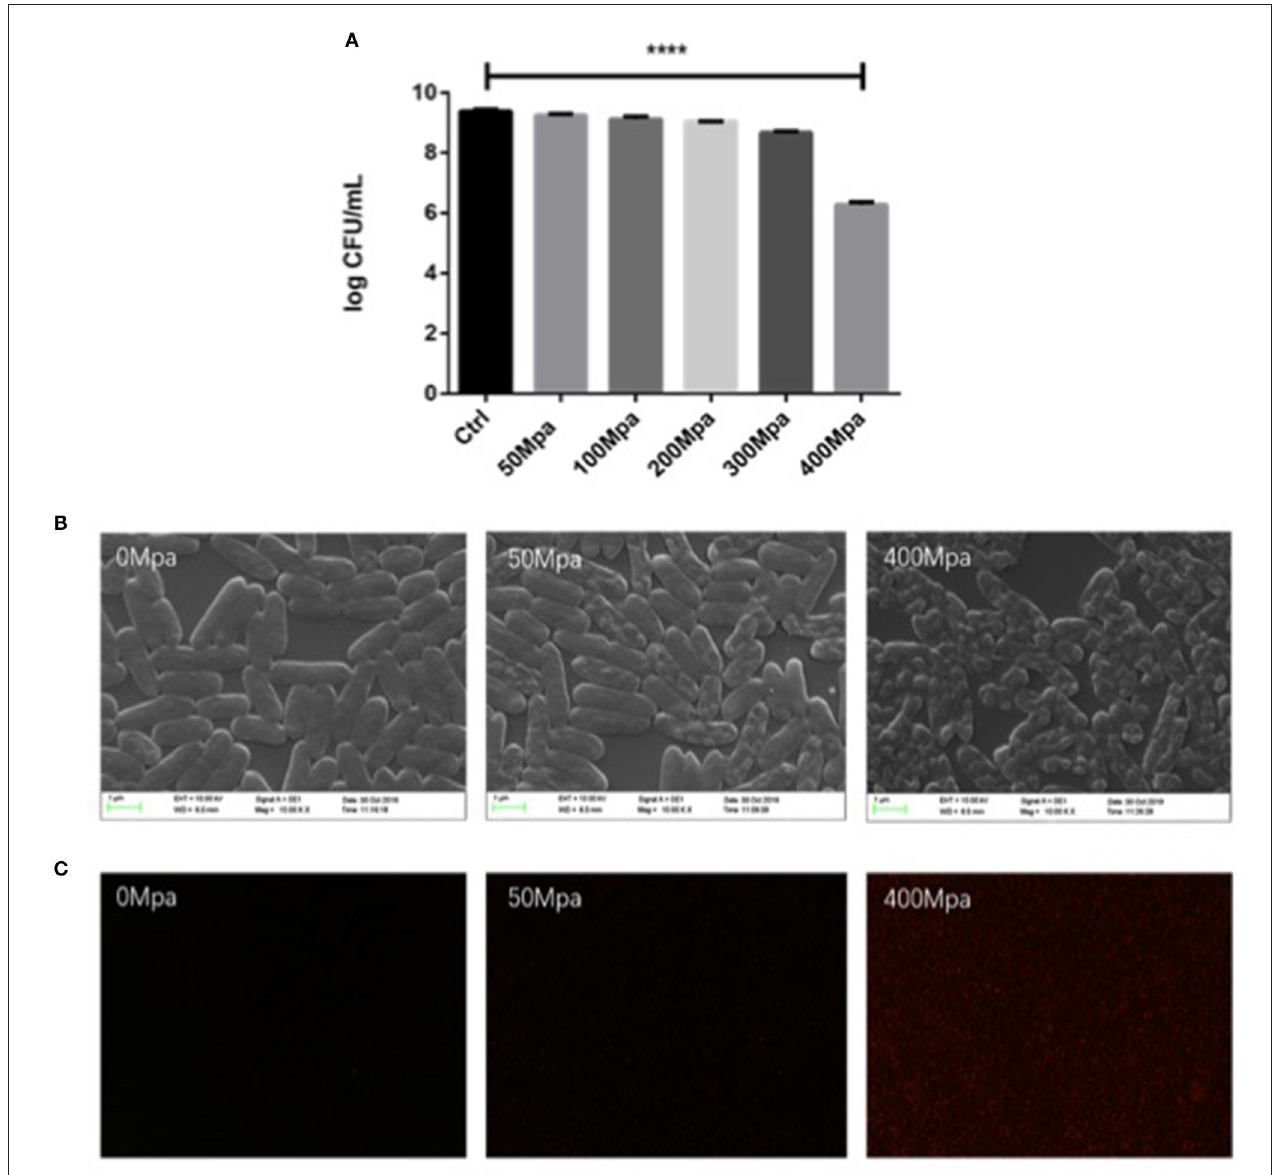
FIGURE 1 | (A) Survival curves of Enterobacter Sakazakii in phosphate buffer with HHP treatment. (B) Scanning electron microscopy (SEM) micrographs and (C) uptake of propidium iodide by E. sakazakii cells. Asterisks indicate difference between control and different high hydrostatic pressures (HHPs) at **** P < 0.0001.